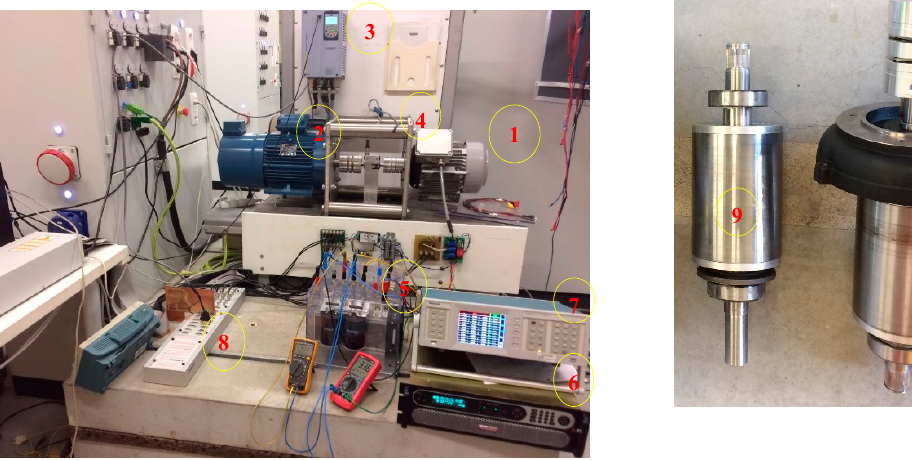
Figure 12. Experimental test bench.